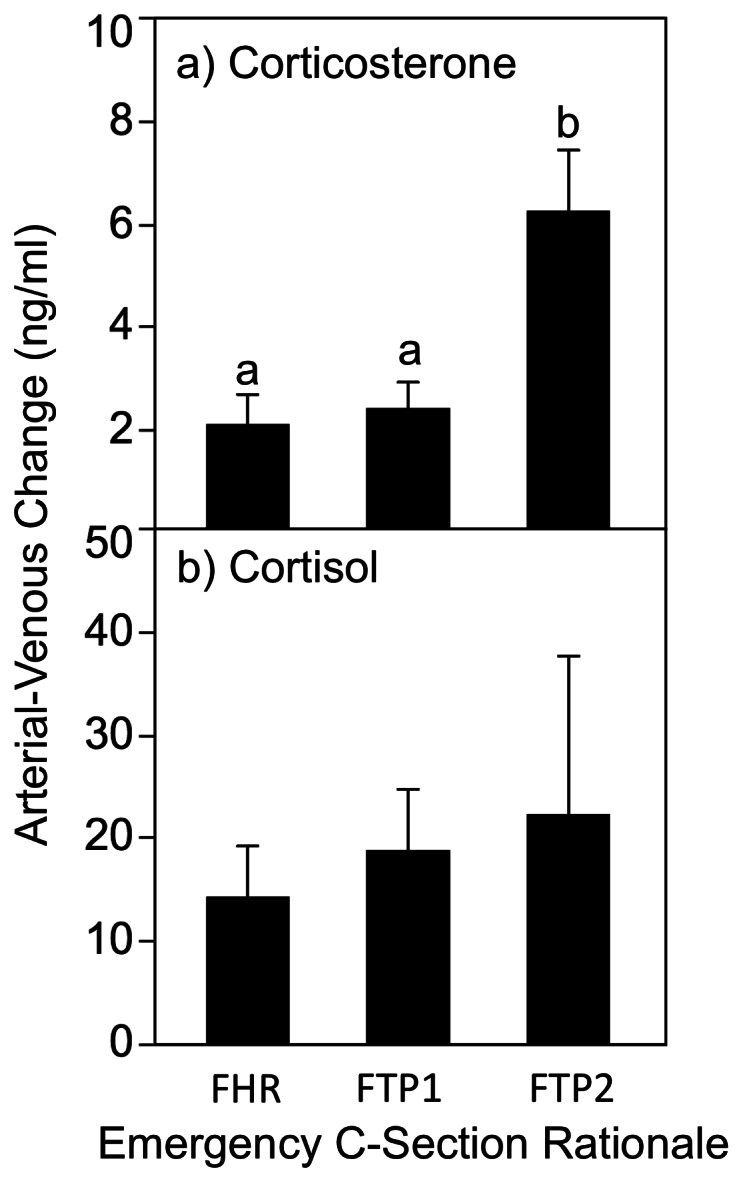
Fetal stress increases fetal corticosterone, but not cortisol, synthesis.For emergent C-sections only (EC: N = 49), absolute increase [A-V] ng/ml in concentration after passage of the fetus for corticosterone (panel a) and cortisol (panel b) in groups stratified by the clinical rationale for the emergent C-section: fetal heart rate abnormalities (FHR: N = 11); Failure to progress in stage 1 (FTP1: N = 19), and failure to progress in Stage 2, representing cephalo-pelvic disproportion detected after a history of labor (FTP2: N = 14). Five EC cases were excluded because the chart record was not clear on the rationale for EC. Letters that differ indicate a significant post-hoc difference between groups, with FTP2 corticosterone higher than FHR and FTP1, following an overall effect of rationale for EC.G.